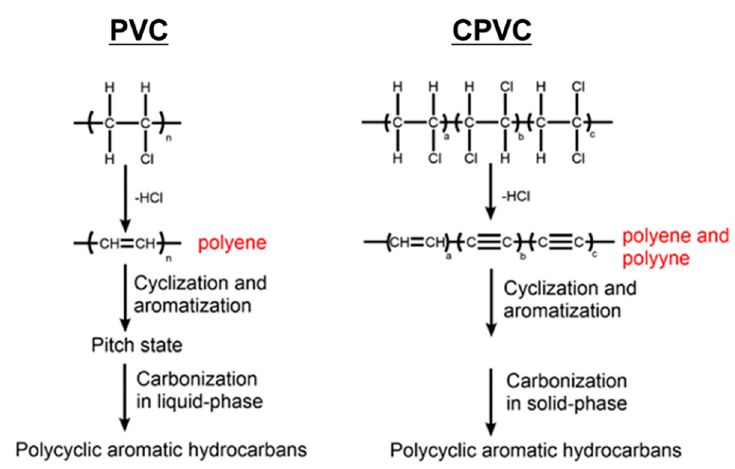
Figure 3. The conjectured mechanisms of decomposition and carbonisation of the PVC and CPVC.